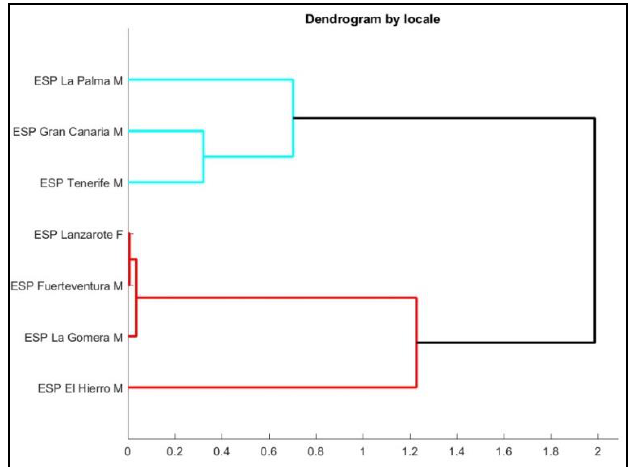
Figure 12. Dendrogram of SVO + Exp interrogative sentences by areas (vertical axis) and distance values along the horizontal axis.